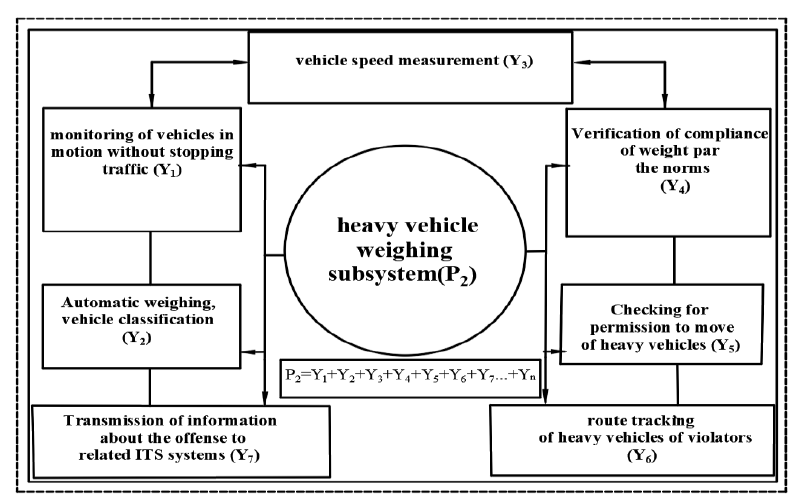
Figure 3. Functional diagram of the weighing subsystem.